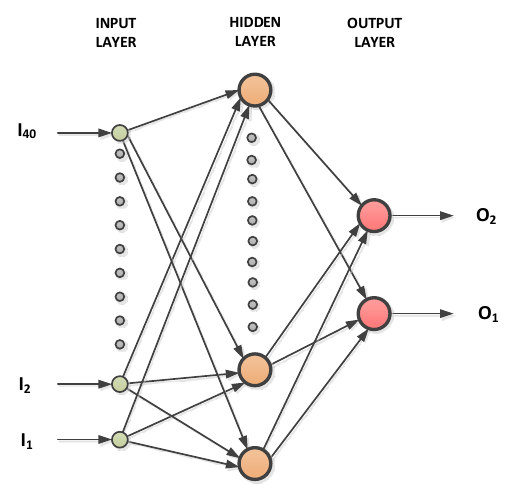
Figure 2. General view of used ANN